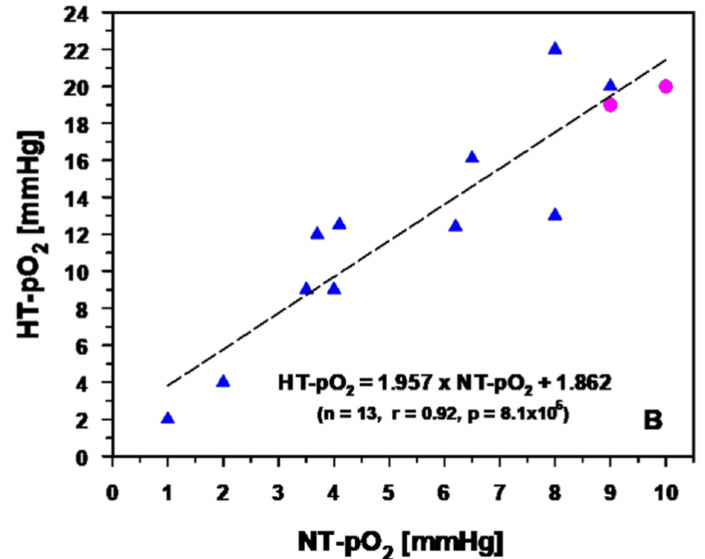
Figure 7. Linear relationship between mean baseline (pre-HT) tumor tissue pO 2 (NT-pO 2 ) and mean post-HT pO 2 values (HT-pO 2 ) in experimental and patient tumors using various heating techniques. In ( A ), the relationship includes normal tissue (dermis) measurements upon heating with water- filtered infrared-A irradiation (wIRA), red dot [67]. Data clearly demonstrate the equivalence of the various heating techniques chosen (blue triangles: microwave heating of rodent tumors; purple dots: microwave heating of patient tumors; red diamonds: wIRA-induced heating of experimental tumors; green square: mean pO 2 value of all data presented). In general, the use of mHT for 30–60 min leads to a 1.6-fold increase in mean pO 2 . In ( B ) only data of hypoxic tumors (mean pO 2 < 10 mmHg) are shown. Here, post-mHT pO 2 values almost